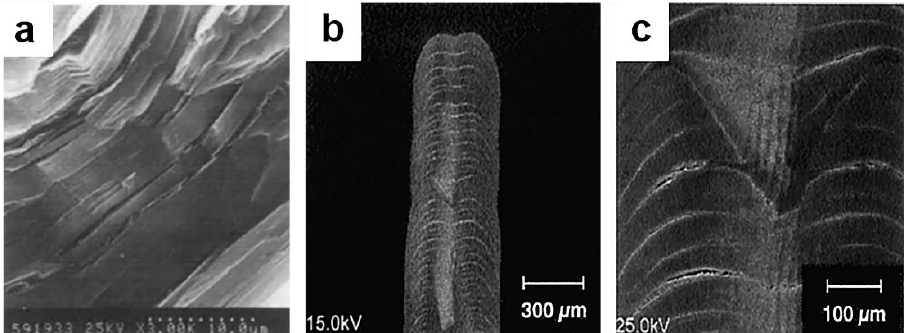
Figure 9. ( a ) SEM of the graphite fiber prepared by CVD of cyanoacetylene at 3000 °C on carbon fiber [107]. Copyright © 2021 Elsevier B.V. and Synthetic Metals. ( b ) Fiber profile, and ( c ) stripe microstructure at center of fiber [108]. Copyright © 2021 Elsevier Ltd. and Carbon.